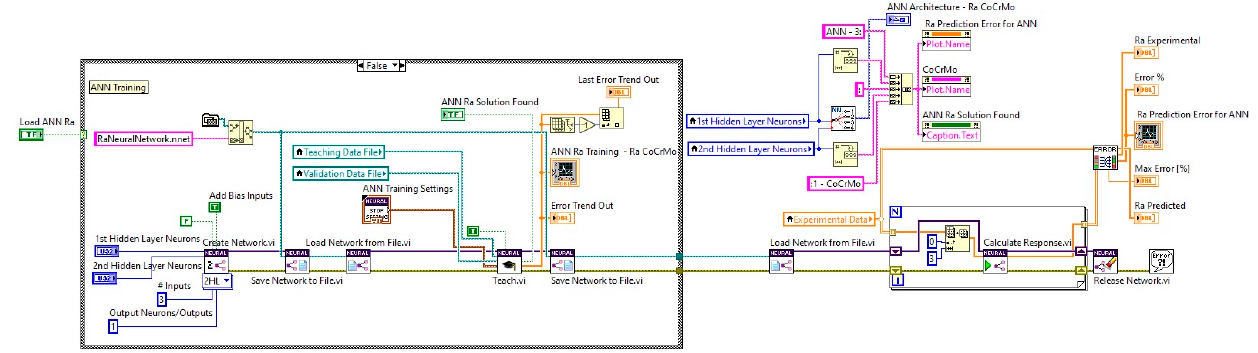
Figure 8. Partial diagram of application software to create, save, teach, test and save an ANN. Because the experimental data sets contain three Ra measurements taken in different areas for each trial, the ANN data set was prepared accordingly to prevent retraining. Based on experimental data sets the ANN was trained by using a different training data set after normalizing the data. Figure 9 shows how different data files were generated using dedicated sub-VIs to produce the teaching and validation data files.